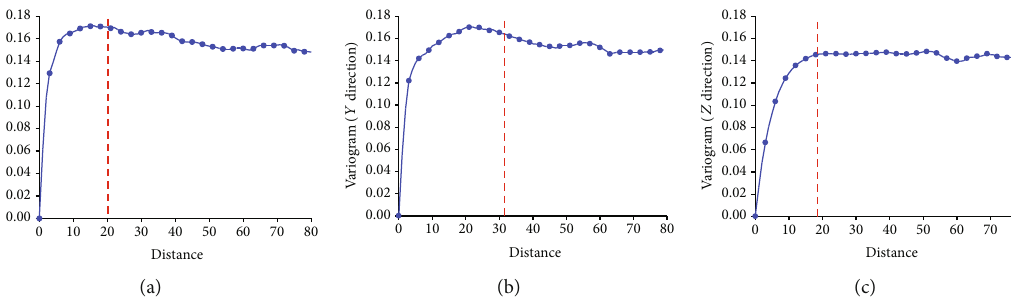
Figure 12: Variogram curves of original volume data (shale) in three directions: (a) X direction; (b) Y direction; (c) Z